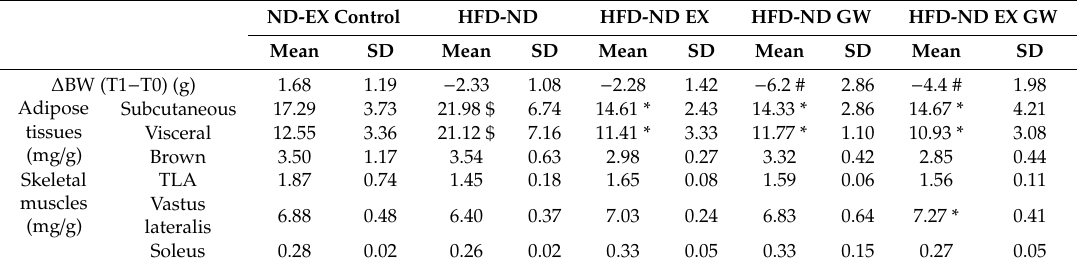
Table 1. Body weight and composition variations according to obesity-treated